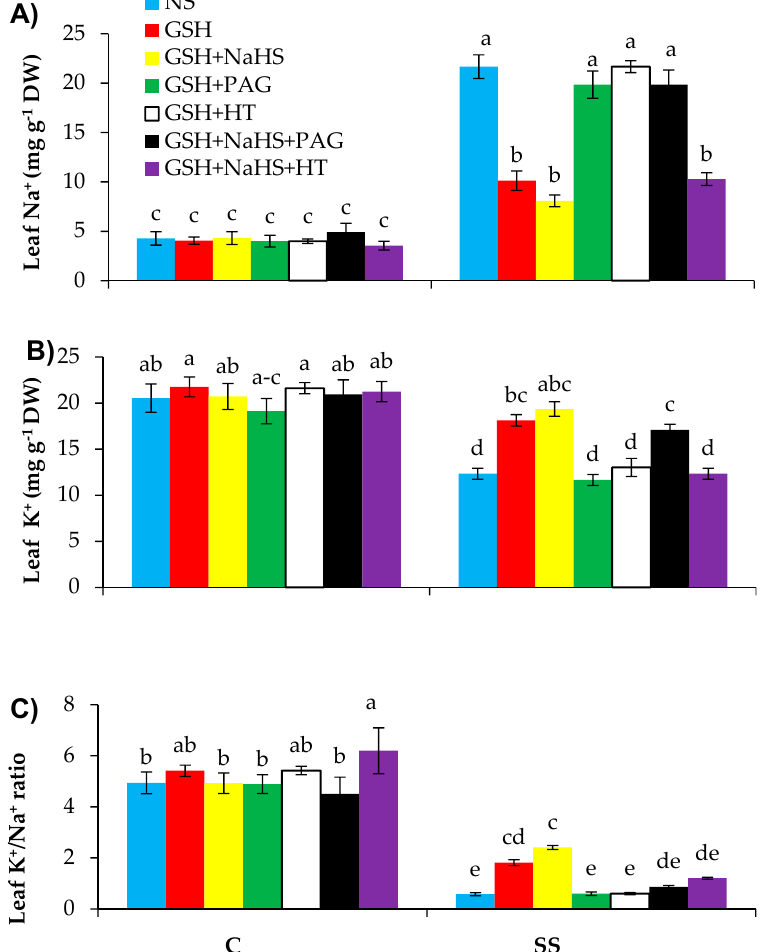
Figure 9. Leaf sodium (Na + ( A )), and potassium (K + ( B )) contents and leaf K + / Na + ratio ( C ) in pepper plants grown under control (C) and salinity stress (SS 100 mmol L − 1 NaCl), sprayed with glutathione (1.0 mmol L − 1 GSH) or sodium hydrosulfide (0.2 mmol L − 1 NaHS) alone or together, combined with a 0.1 mmol L − 1 scavenger of H 2 S, hypotaurine (0.1 mmol L − 1 HT), or inhibitor of l -DES, dl -propargylglycine (0.3 mmol L − 1 PAG). (Mean ± SE). Mean values carrying di ff erent letters within each parameter di ff er significantly ( p ≤ 0.001) based on Duncan’s multiple range test.